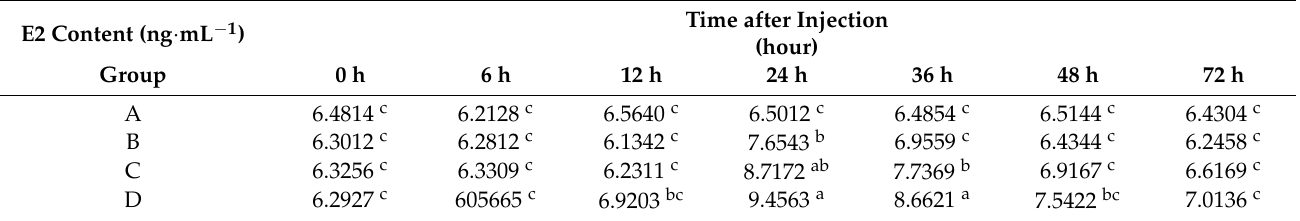
Table 2. Change of serum E2 content in Nile tilapia serum after oxytocin injection.